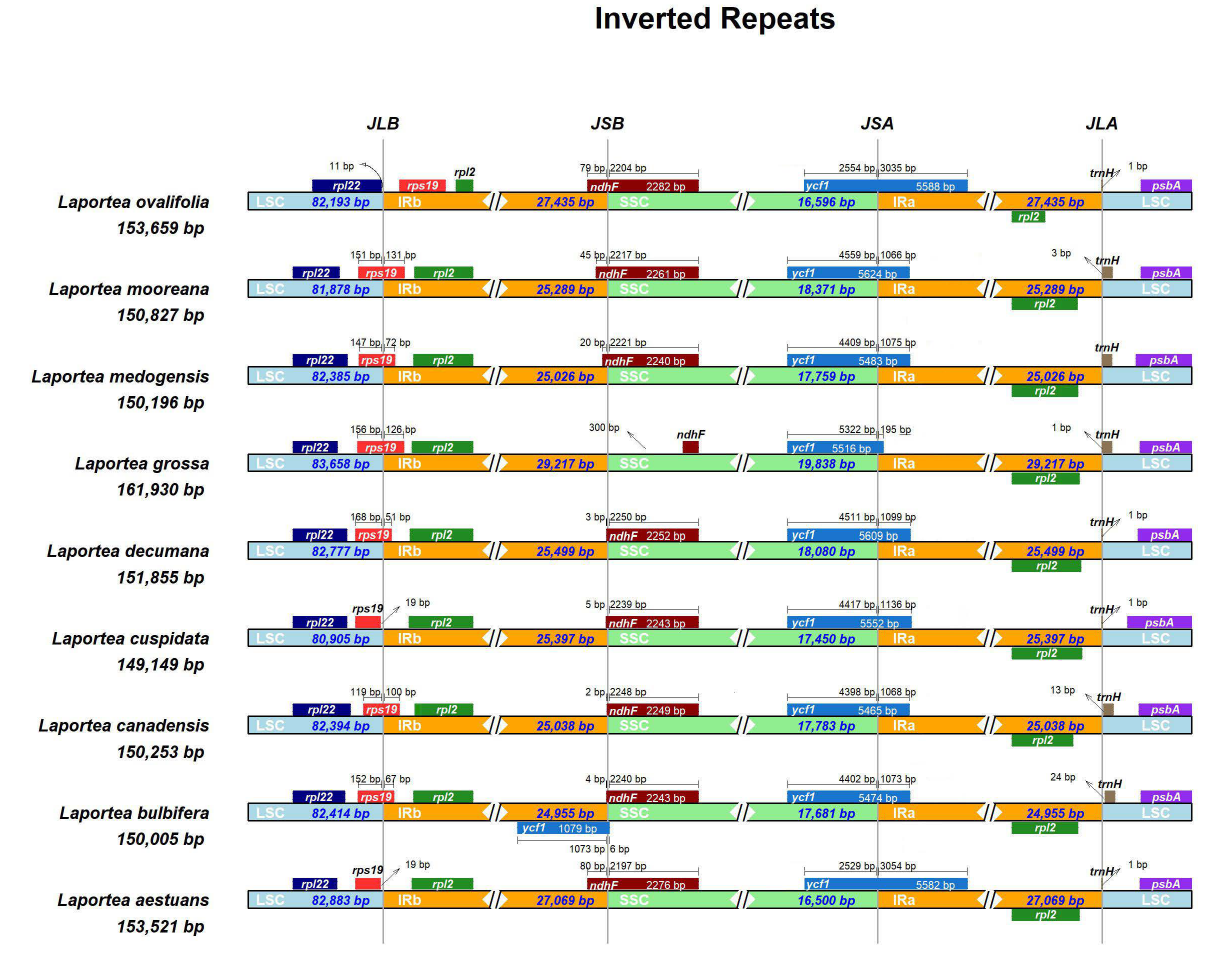
Figure 4. Comparisons of the borders of large single copy (LSC), small singe copy (SSC), and inverted repeats IR regions (IR) among 9 Laportea chloroplast